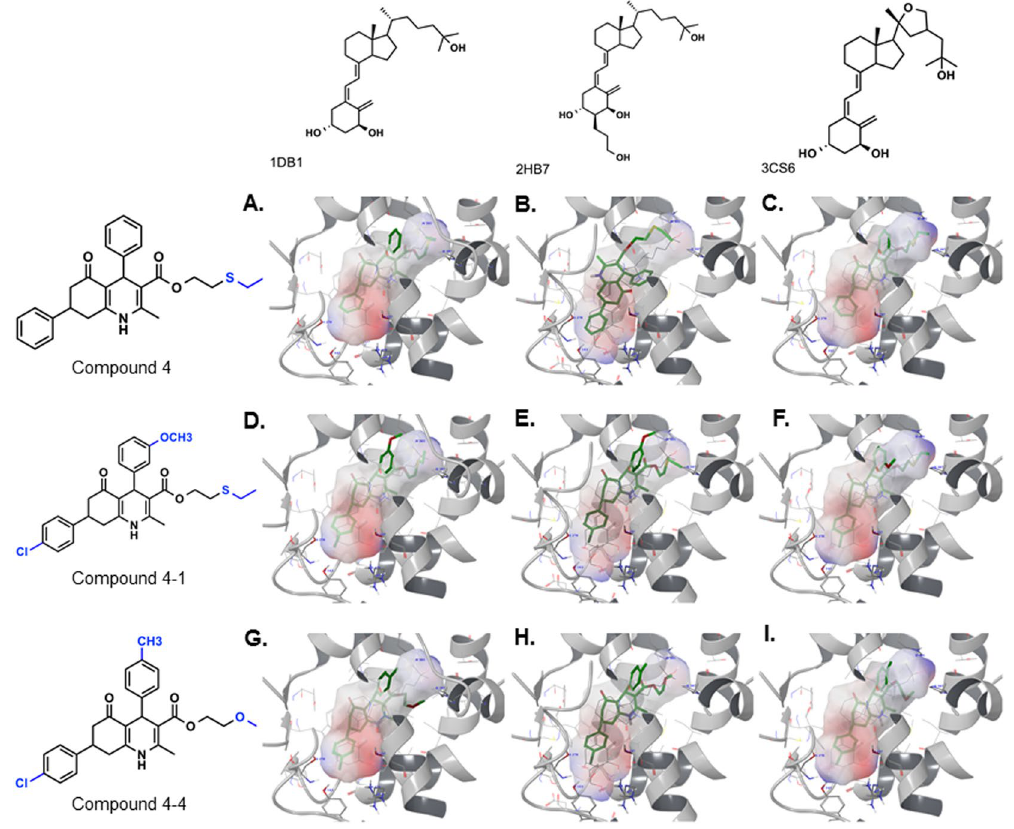
Figure 2. Binding of lead compounds VDR 4, VDR 4-1, and VDR 4-4. The long hydroxypropyl side chain on A-ring of 2HB7-ligand induces A-ring subpocket, whereas cyclized side chain on D-ring of 3CS6-ligand locally alter conformation of amino acid side chains. Binding poses (green, thick sticks) of VDR 4 (upper panel), VDR 4-1 (middle panel) and VDR 4-4 (lower panel) as predicted by Glide XP docking in 1DB1 (upper panel), 2HB7 (middle panel), and 3CS6 (lower panel) crystal structures. The space occupied by co-crystallized ligand in respective structures is represented as semi-transparent electrostatic surface (ESP) for relative binding comparison along with respective co-crystallized ligand shown in black wire bond representation seen within ESP surface. The residues within 3 Å distance of ligand are displayed in black wire bond representation, while secondary ribbon structure (shown in gray) is shown for residues within 10 Å of ligand, the 3 residues of helix (aa. 231–233) passing across the pocket are un-displayed for better pocket